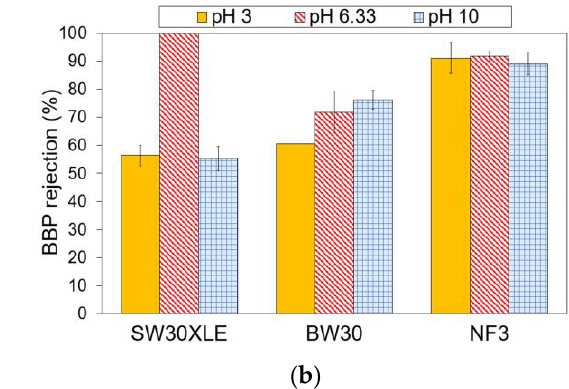
( b ) Figure 8. Performance stability of NF3 membrane as a function of time in filtrating ( a ) DBP (10 ppm) and ( b ) BBP (2 ppm) solution at pH ~6.3. Based on the FTIR spectra shown in Figure 9a, it was obvious that several peaks of the pristine NF3 membrane were altered after it was used for DBP and BBP filtration. The intensities of peaks at 3000–3500 cm −1 region and ~1737 cm −1 were reduced, and this was mainly due to the membrane surface fouling caused by the deposition/adsorption of